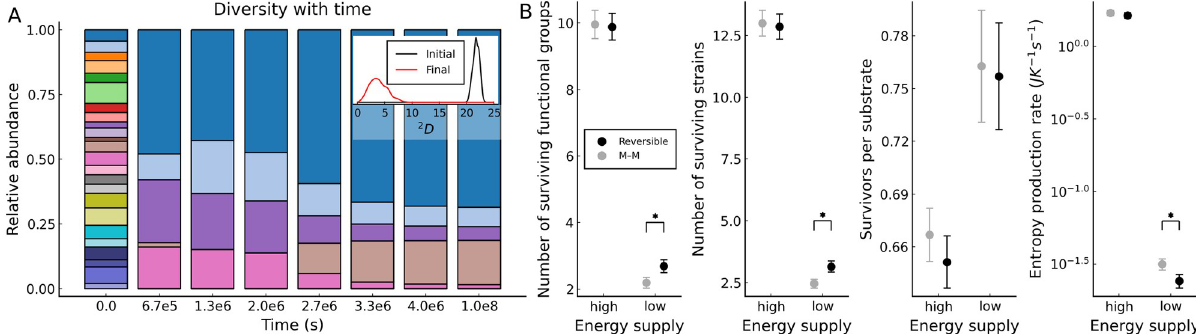
Fig 3. Free-energy availability increases species diversity. A : Relative abundances of functional groups over time. The inset density plot shows initial and final distributions of inverse Simpson’s diversity indices for functional groups across 250 simulations (using the same simulation parameters as Fig 2). B : Comparisons between the four free-energy × reversibility regimes. For each regime, the average and 99% confidence intervals obtained from 250 simulations are plotted. Two values of the total free-energy of the supplied substrate are considered: high (1.5 × 10 7 J mol − 1 ), and low (1.5 × 10 6 J mol − 1 ). For both energy regimes, we consider both reversible (black symbols) and Michaelis–Menten (M–M grey symbols) kinetics. Cases with a significant difference between these pairs are marked with a star ( P < 0.01). The greatest differences are seen between high (labile) and low (recalcitrant) free-energy substrates, and only in cases of low free-energy does the kinetic scheme used cause significant differences.